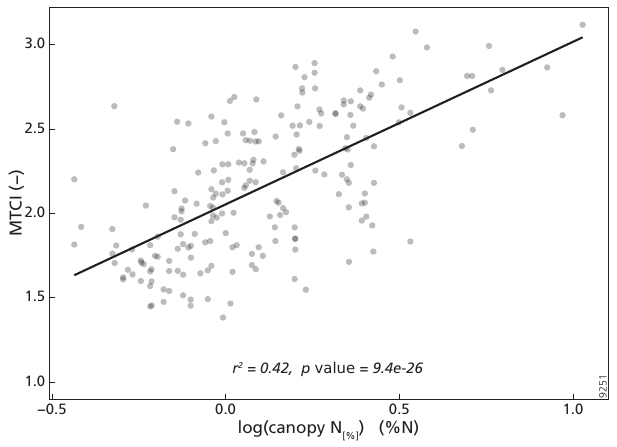
Figure 4. Scatterplot between the MTCI (–) and canopy nitrogen concentration (canopy N [ % ] , %N) after resampling the datasets to 20km spatial resolution ( n =